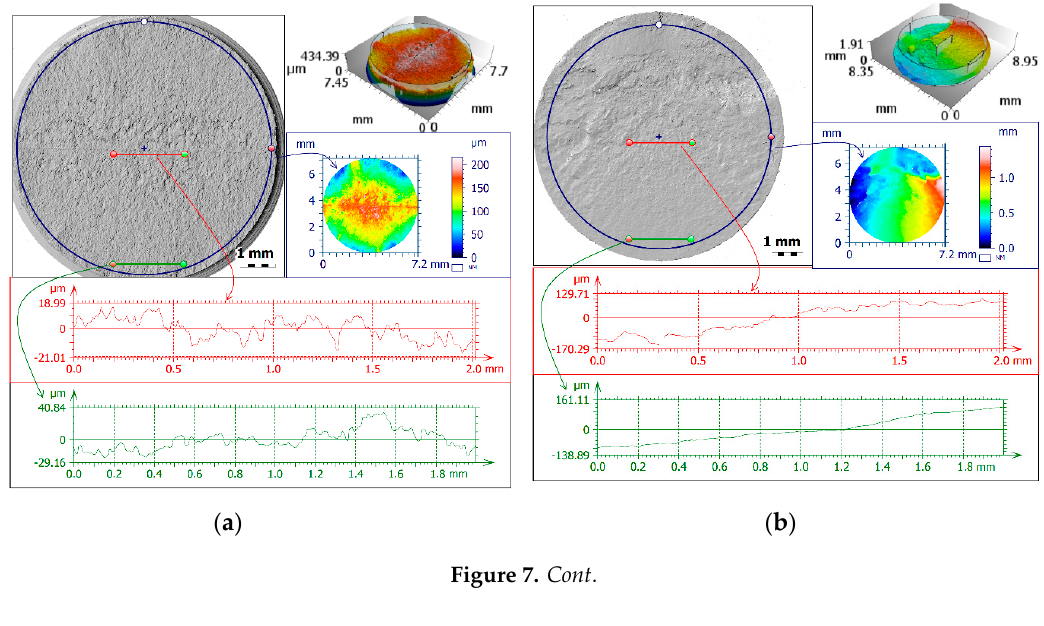
Figure 6. ( a ) Side view of S355J2 sample (lines show the place of initiation); ( b ) AW-2017A-T4 aluminium